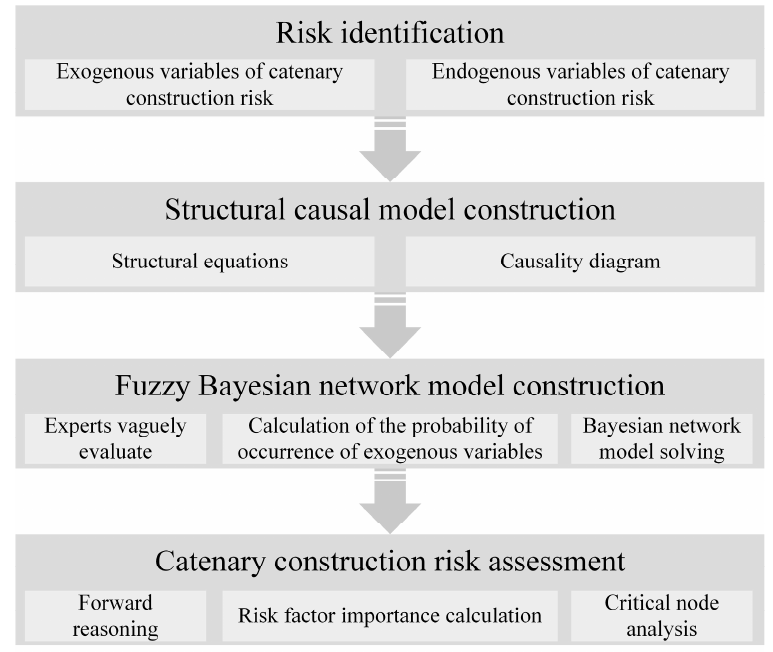
Figure 1. A fl ow chart of risk assessment during catenary construction. Figure 1. A flow chart of risk assessment during catenary